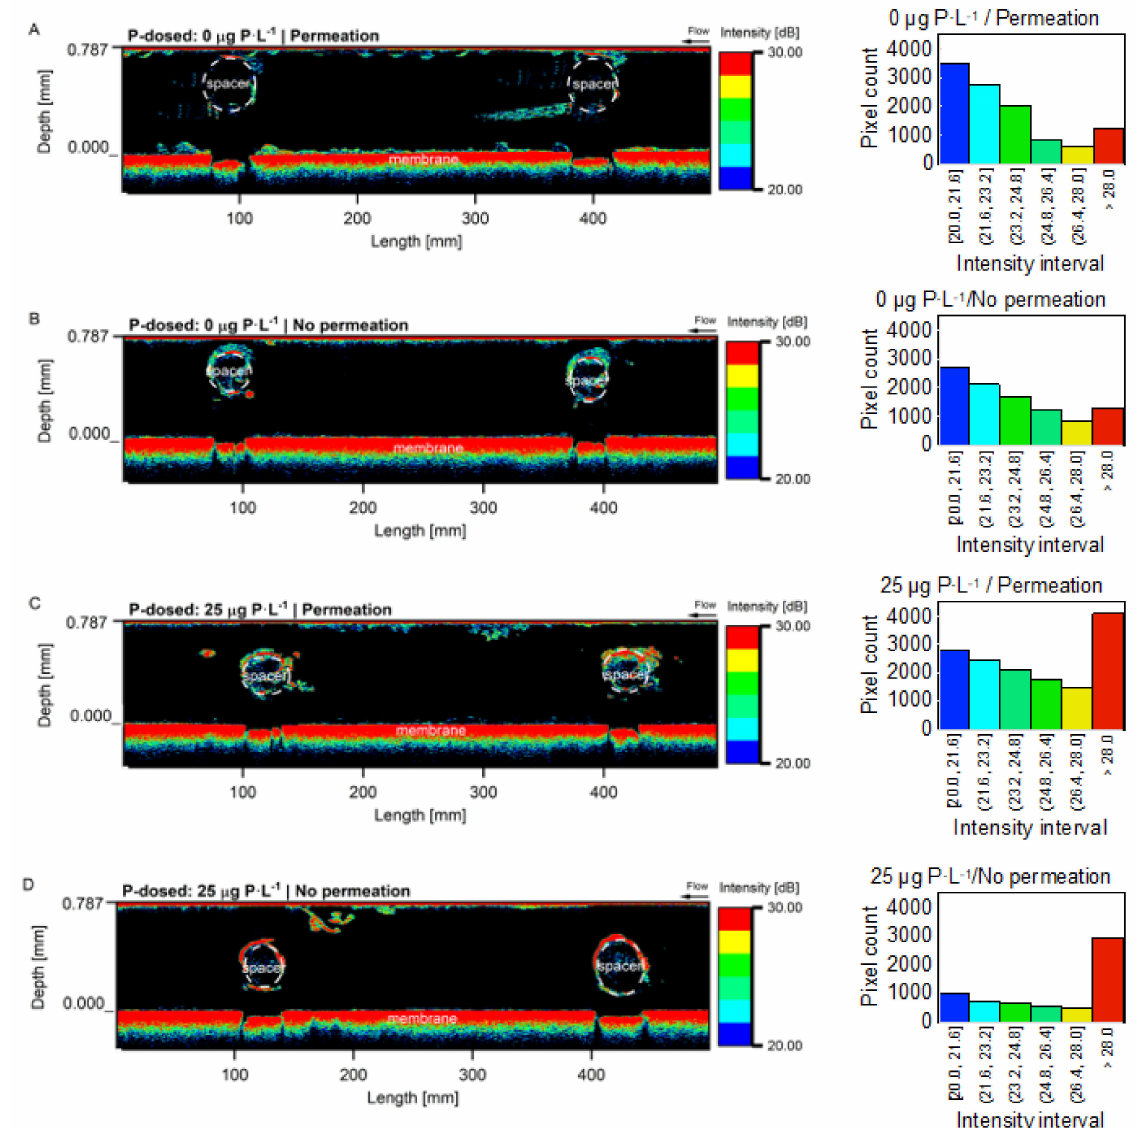
Figure 5. OCT images of biofilm with quantification of the intensity profile after 4.7 days of MFSs oper- ation. Two-dimensional OCT images of the biofilms grown at ( A , B ) 0 µ g P · L − 1 and ( C , D ) 25 µ g P · L − 1 under permeation at a constant flux of 15.6 L · m 2 · h − 1 and no permeation conditions with a dosed assimilable organic carbon concentration of 250 µ g C · L − 1 in the feed water. The OCT signal intensity was used to describe biofilm properties, with higher intensity resulting from a more light-scattering biofilm. The arrows indicate the crossflow